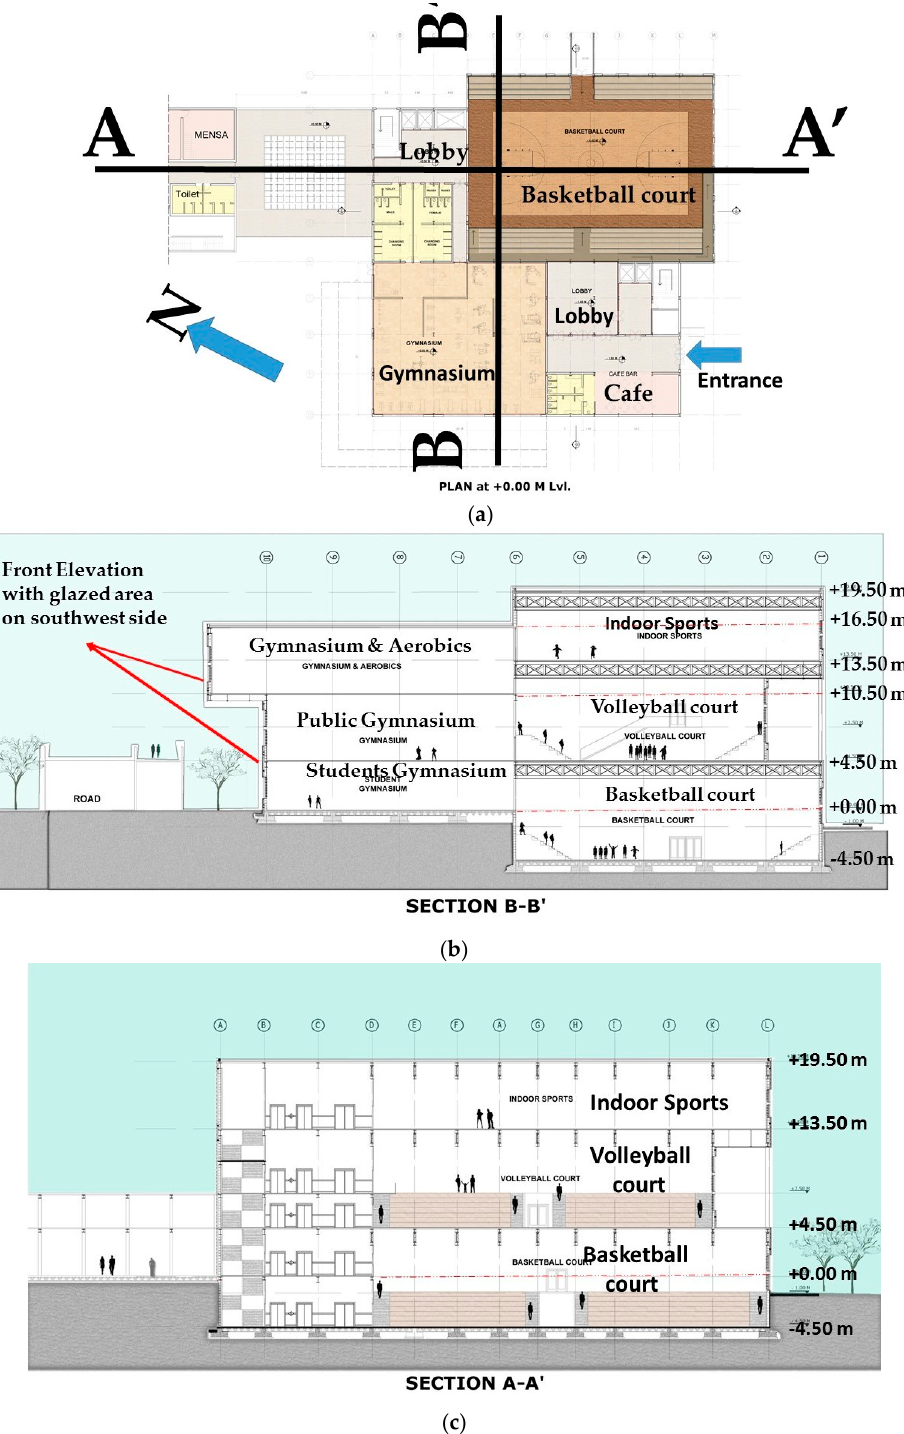
Figure 2. ( a ) Plan of the gymnasium building at +0.0 m level; ( b ) section AA’ of the gymnasium building; ( c ) section BB’ of the gymnasium building.